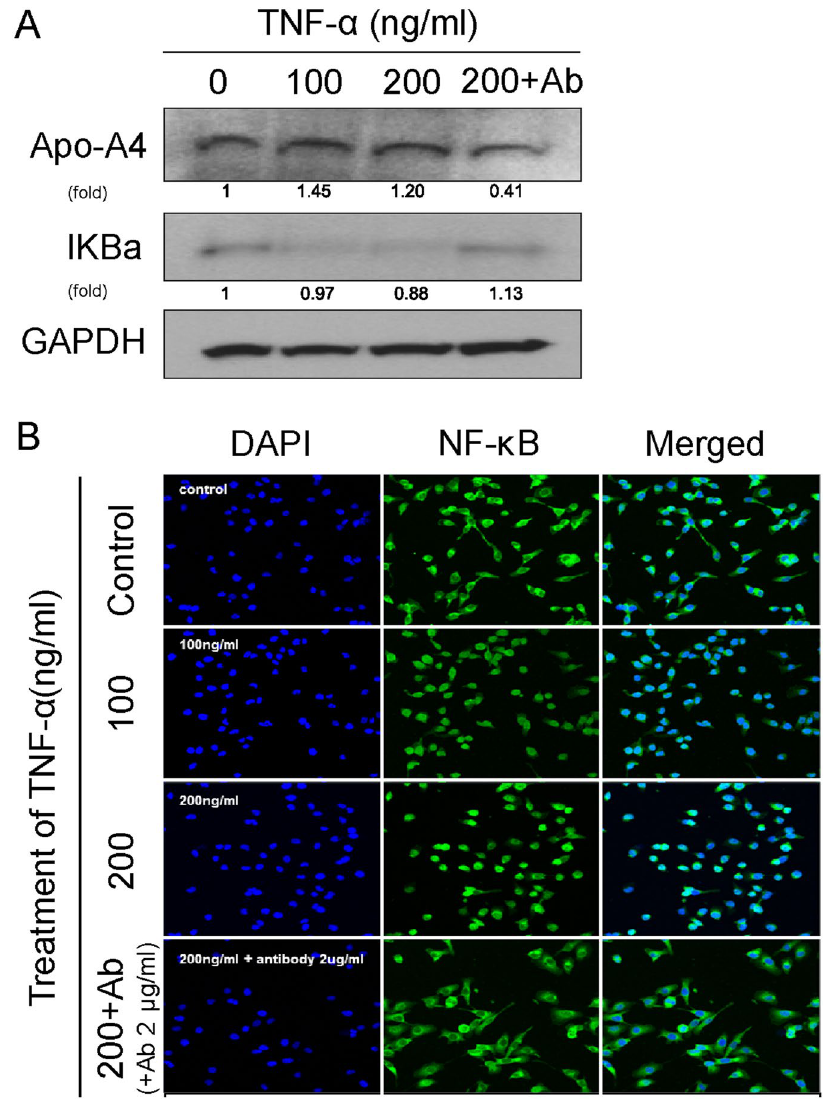
Figure 5. Inflammatory AKI increases apo-A4 expression through the NF- κ B complex. ( A ) Western blotting revealed an inverse relationship between apo-A4 and I κ B protein expression in HK-2 cells following TNF- α treatment. The loading control was GAPDH and the normalized ratio of each extract pair (A set to 1) determined using Image Jv1.42q software (http://rsb.info.nih.gov/ij). (B ) Immunofluorescence assay for apo-A4 and NF- κ B expression in HK-2 cells after 24-h TNF- α treatment. TNF- α antibody was used to neutralize the TNF- α effect. NF- κ B (green) immune-localization is shown. And NF- κ B regulates apo-A4 (see Supplementary Fig.